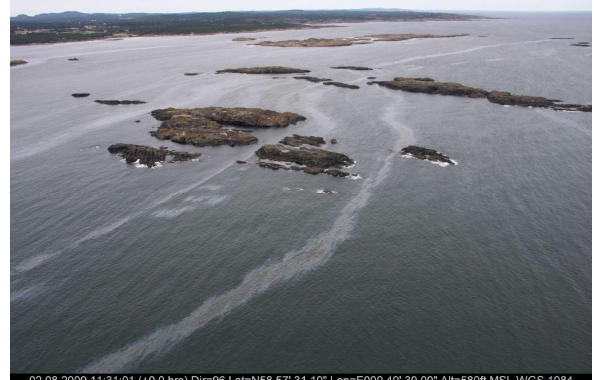
Figure 12: Example of oil that is advected through a very complex topography. (Photo: NCA) Fig. 12. Example of oil that is advected through a very complex topography. (Photo: